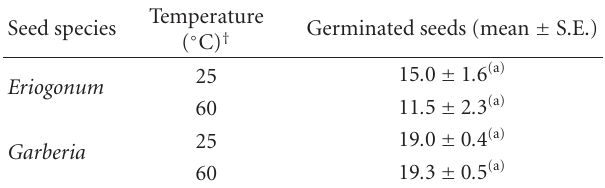
species indicate no di ff erence in germination between temperature treatments ( t -test, P > .